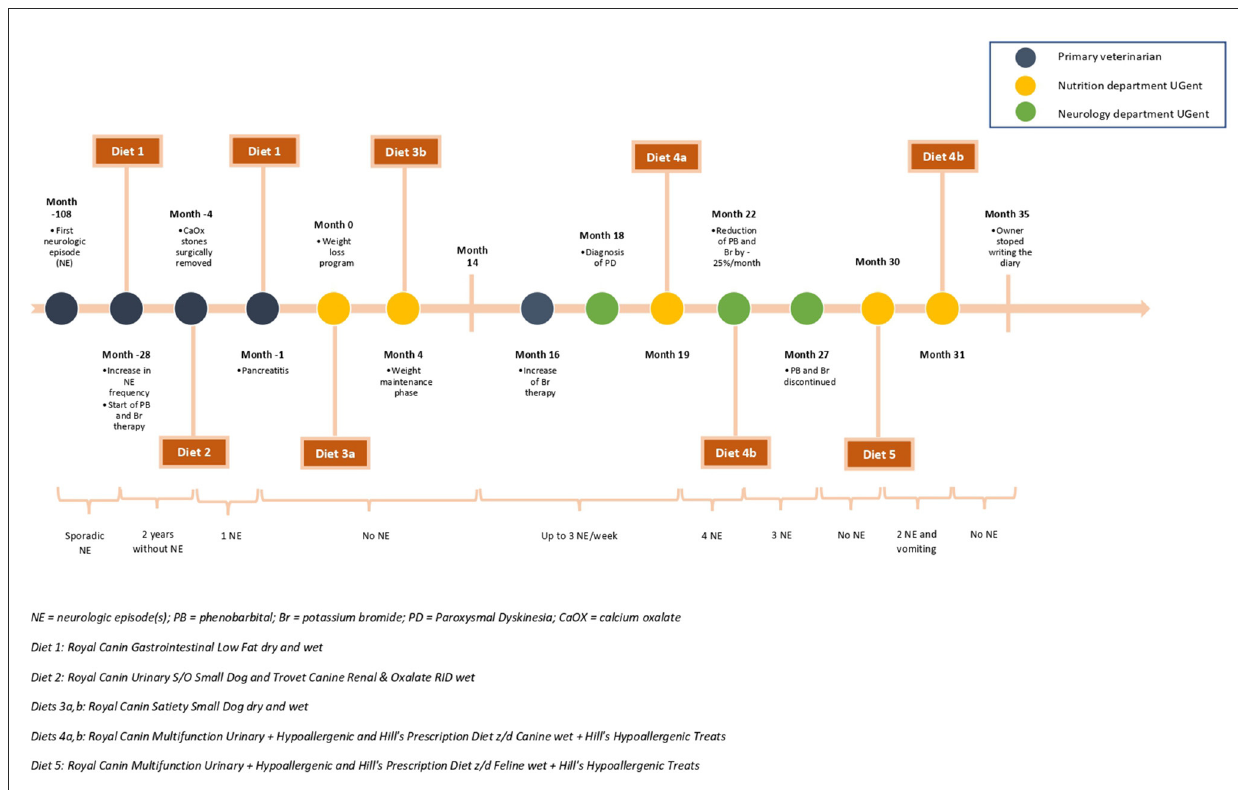
FIGURE1 Timeline showcasing most important events, neurological episodes (NE), anti-seizure drugs and dietary changes.